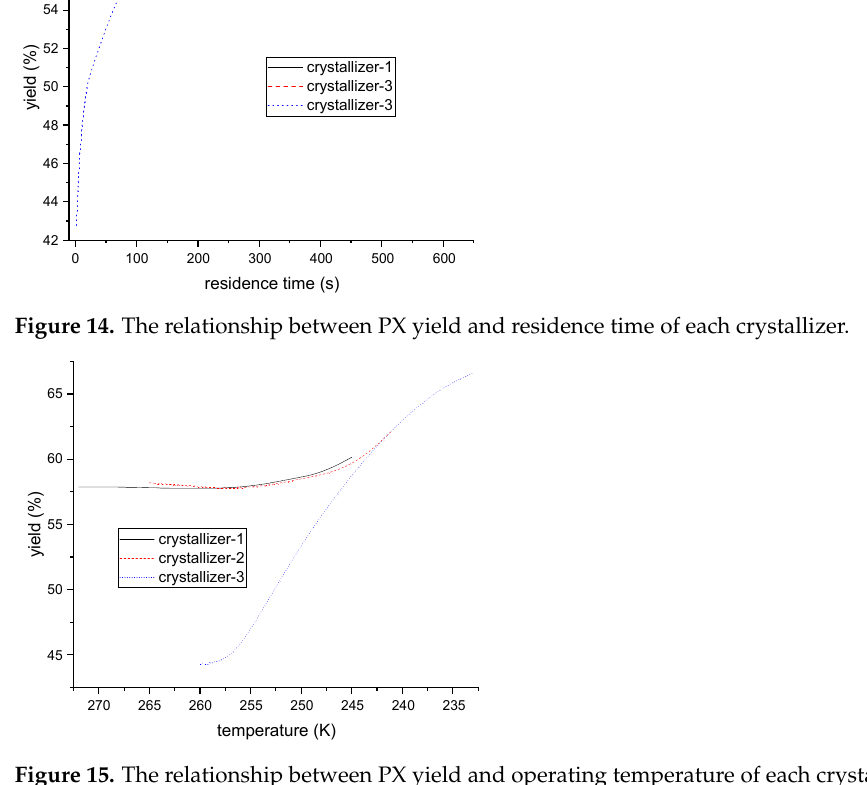
Figure 15. The relationship between PX yield and operating temperature of each crystallizer.